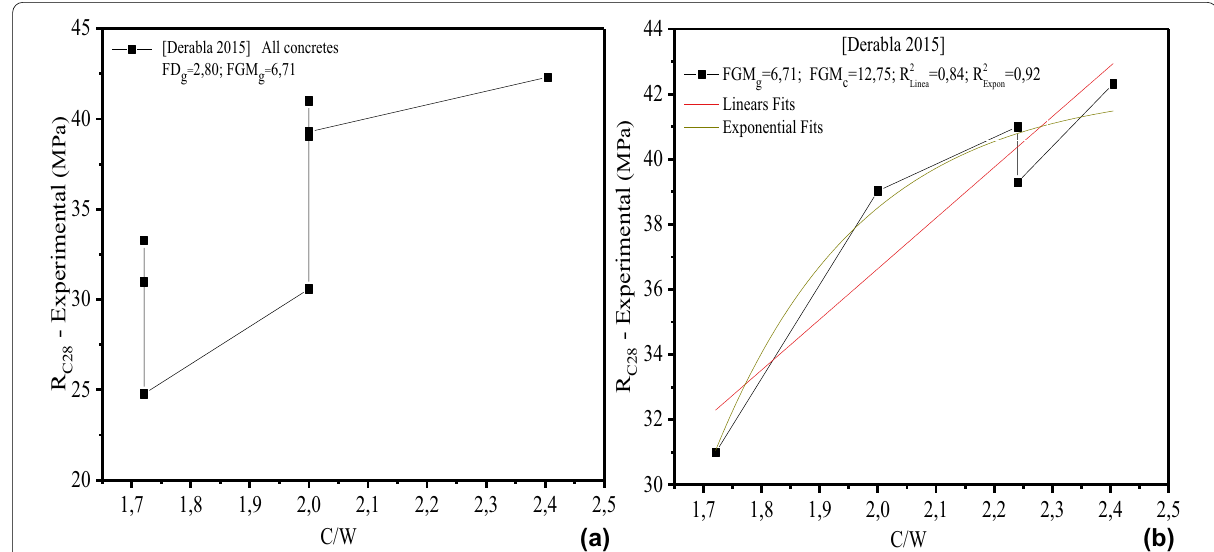
Fig. 15 Evolution of R C28 as a function of the ratio C / W (Derabla and Benmalek 2014). a Results of all the concretes obtained by FGM g , b results obtained by FGM g and ( FD C )